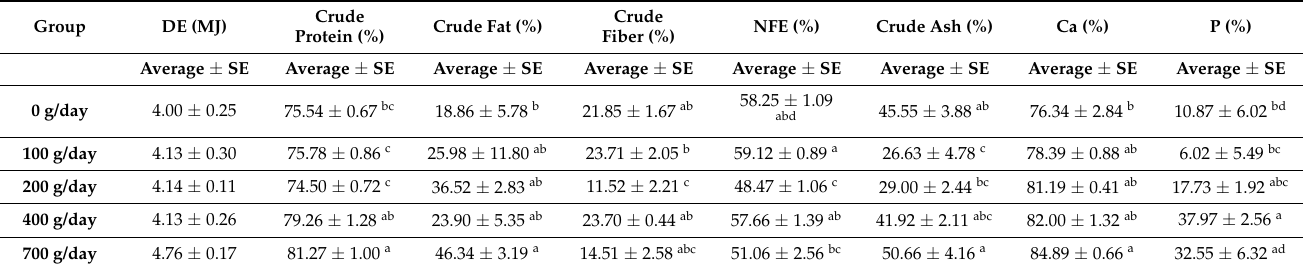
Table 4. Nutrient digestibility (%) depending on daily doses of milk thistle seed cakes.